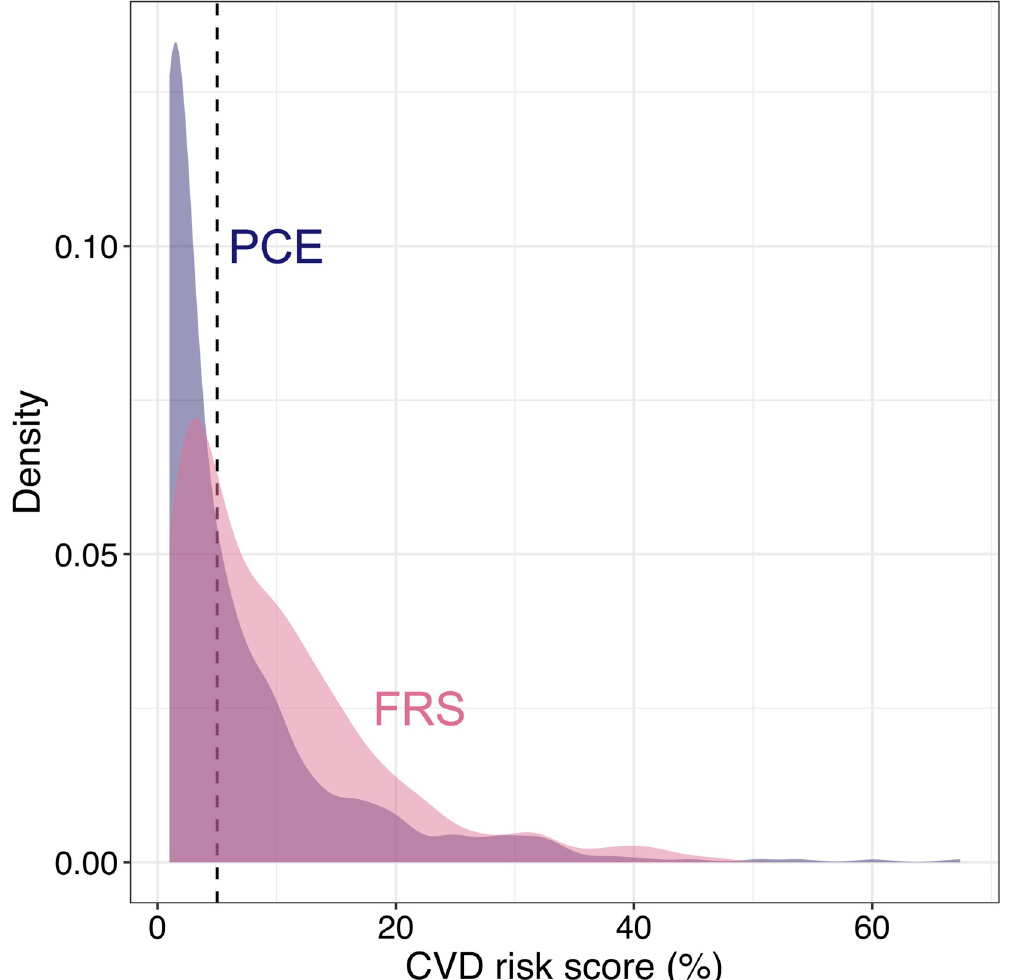
Fig 4. Distribution of Framingham risk score (FRS) and pooled cohort equation (PCE) in longitudinal set. Pink- and blue-colored density plots corresponds to FRS and PCE, respectively. The grey dotted line indicates the cut-off value for dichotomization